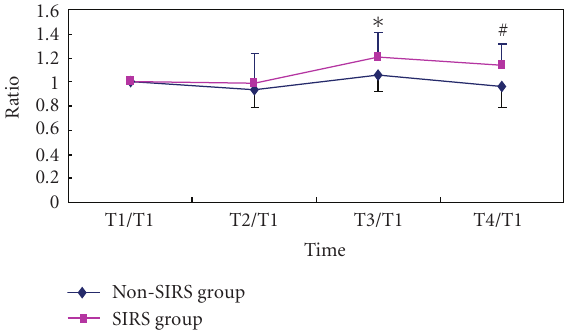
Figure 3: Upregulation of TLR2 expression on PBMC. Mean ± SD ( n = 12 for SIRS; n = 15 for non-SIRS); ∗ P < . 01, # P < . 05, compared with T1/T1.